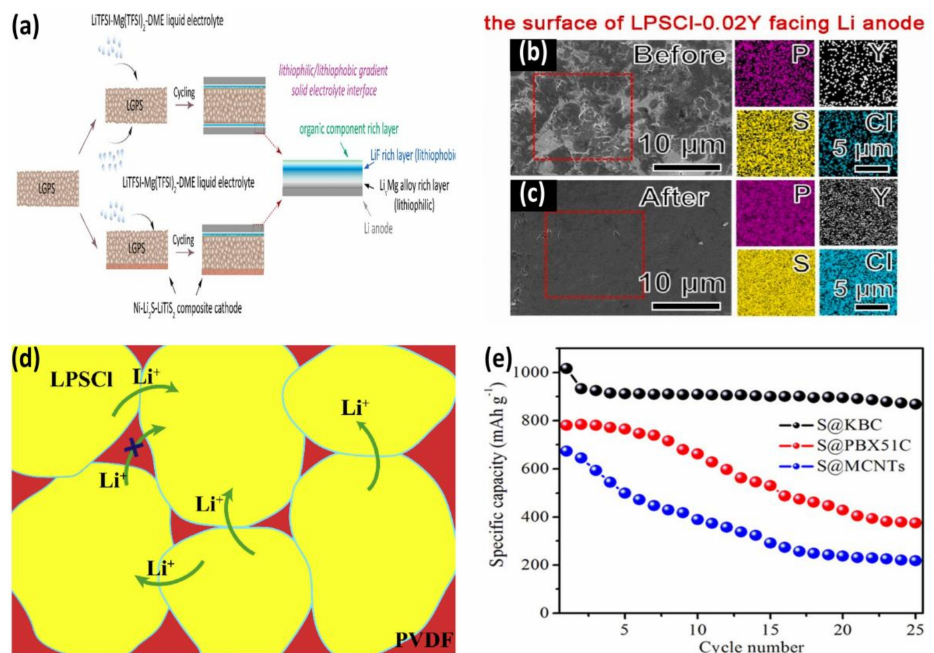
Figure 5. ( a ) In situ formation of LixMg/LiF/polymer and the solid electrolyte interface between Li and LGPS (Reprinted with permission from [67]; Copyright 2021, ACS Energy Letters). ( b ) The SEM image and EDS mapping results of the interface between solid electrolyte and Li anode after 100 cycles are ( b ) LPSCl − 0.02Y before 100 cycles and ( c ) LPSCl − 0.02Y, respectively (Reprinted with permission from [68]; Copyright 2022, Journal of Power Sources). ( d ) Schematic diagram of the microstructure of LPSCl/PVDF composite electrolyte (Reprinted with permission from [69]; Copyright 2020, Journal of Materiomics). ( e ) Cycling performance of PYR 13 TFSI − modified LGPS in different sulfur/carbon composite LSB electrodes (Reprinted with permission from [70]; Copyright 2019, Journal of